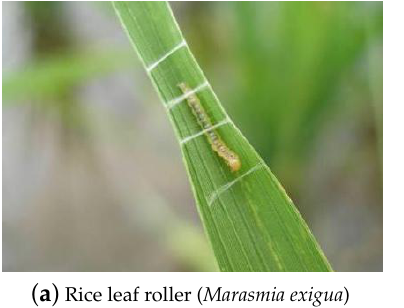
Figure 4. Examples of insect images taken from the IP102 data-set